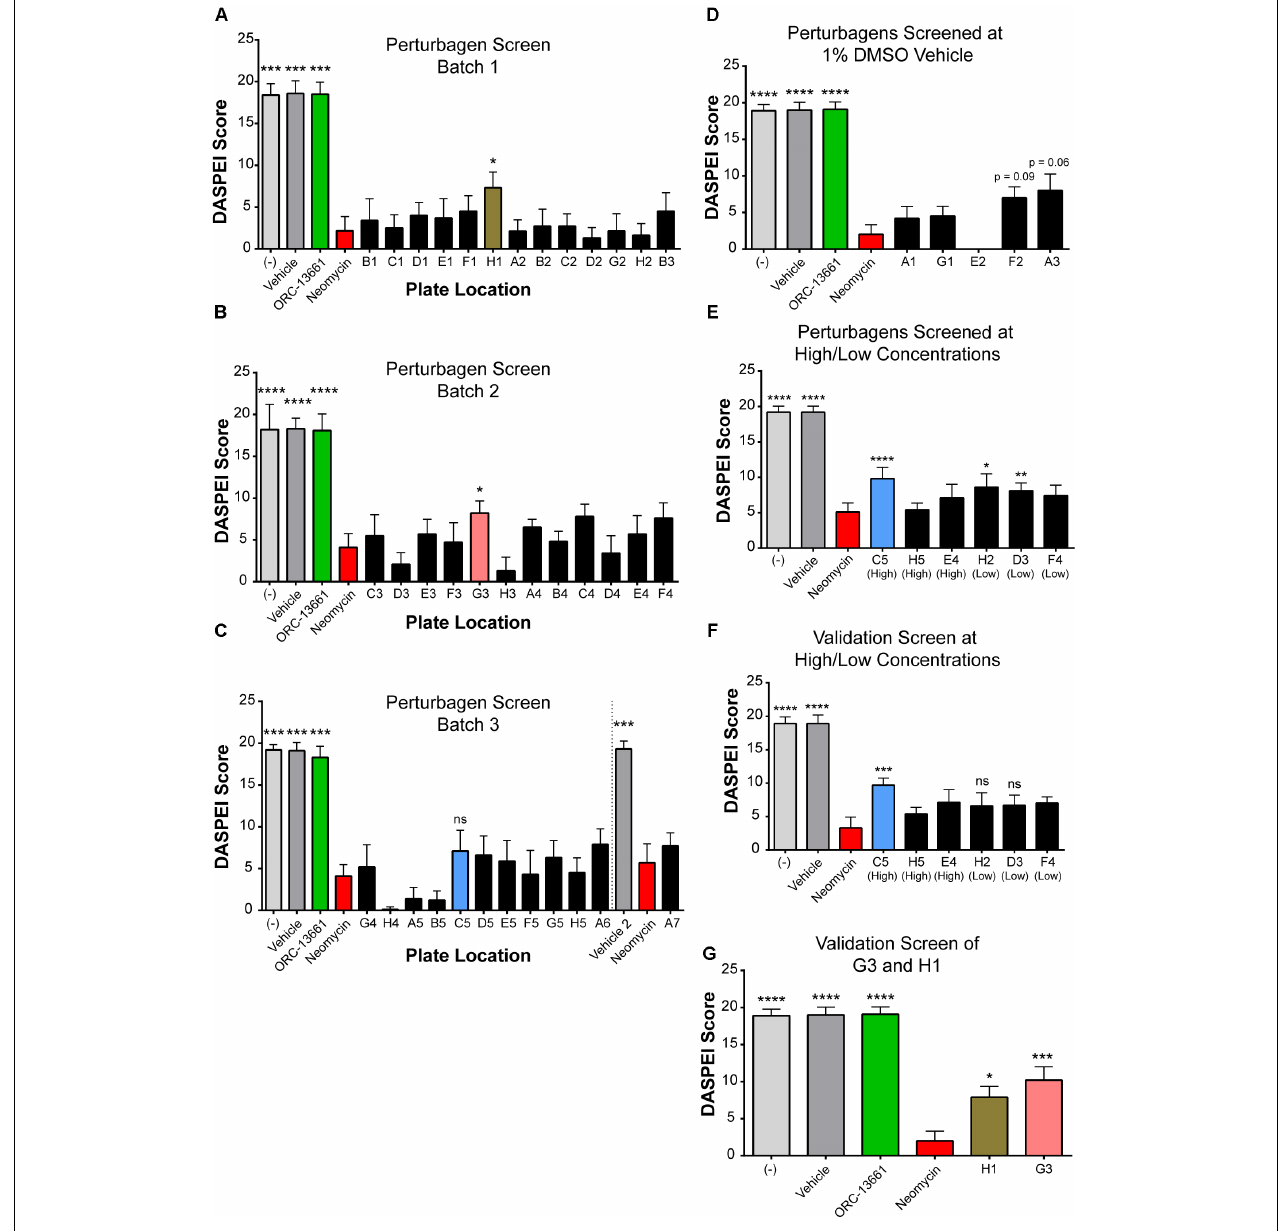
FIGURE 4 | LINCS-identified perturbagen screening in zebrafish revealed three compounds that protect against neomycin-induced hair cell death in lateral line neuromasts. (A–D) DASPEI screening of perturbagens against neomycin-induced ototoxicity in zebrafish neuromasts. Negative controls (–) are shown in light gray ( n = 5–10 zebrafish per bar); vehicle controls (0.1–1% DMSO or 0.1% ethanol) are shown in gray ( n = 5–10), and positive controls with the otoprotective compound ORC-13661 are shown in green ( n = 5–10). 200 µ M neomycin (red) resulted in significant hair cell death ( n = 10–20). Perturbagens that were either not protective or were protective but failed to replicate in a validation experiment are shown in dark gray. Three perturbagens, designated according to their locations on the culture plate as C5 (blue), G3 (pink), and H1 (brown), were protective against neomycin-induced hair cell death in this screen ( n = 10 for all perturbagen treatment bars). (A) DASPEI scores from the first screen of perturbagens tested at 10 µ M against 200 µ M neomycin. H1 (AT-13387, brown) was protective in this batch. (B) DASPEI scores from the second batch of perturbagens screened at 10 µ M against 200 µ M neomycin. G3 (Pifithrin- µ , pink) was identified as a protective hit in this batch. (C) Third batch of compounds screened at 10 µ M against 200 µ M neomycin. C5 (AEG 3482, blue) was later identified as a hit at a different concentration but was not significantly protective at 10 µ M ( p > 0.05). (D) Remaining batch of perturbagens screened at 1% DMSO and 10 µ M concentration to increase solubility. (E) DASPEI scores using a batch of compounds at alternative high or low doses. C5 was identified as a hit at 30 µ M. (F) DASPEI scores from the C5 validation screen of alternative high or low dose compounds. (G) DASPEI scores from the validation experiment for 10 µ M H1 and 10 µ M G3 hits demonstrating a repeatable protective effect against 200 µ M neomycin. Asterisks represent adjusted p-values for Dunn’s multiple comparisons test following a Kruskal–Wallis test for treatment with ∗ representing p ≤ 0.05, ∗∗ representing p ≤ 0.01, ∗∗∗ representing p < 0.001, ∗∗∗∗ representing p < 0.0001, and ‘ns’ (not significant) representing p > 0.05. All error bars in (A–G) represent ± SD